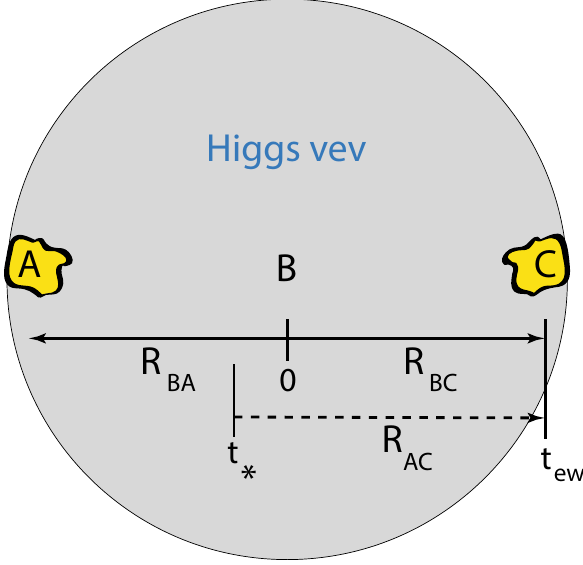
Fig. 1 Schematic diagram showing observer B connecting causally with two opposite patches (A and C) in the Higgs vev, a proper distance R BA ( t ) = R BC ( t ) away. Patch A emitted a light signal at time t ∗ that reached C, a proper distance R AC ( t ew ) away, at the electroweak phase transition time t